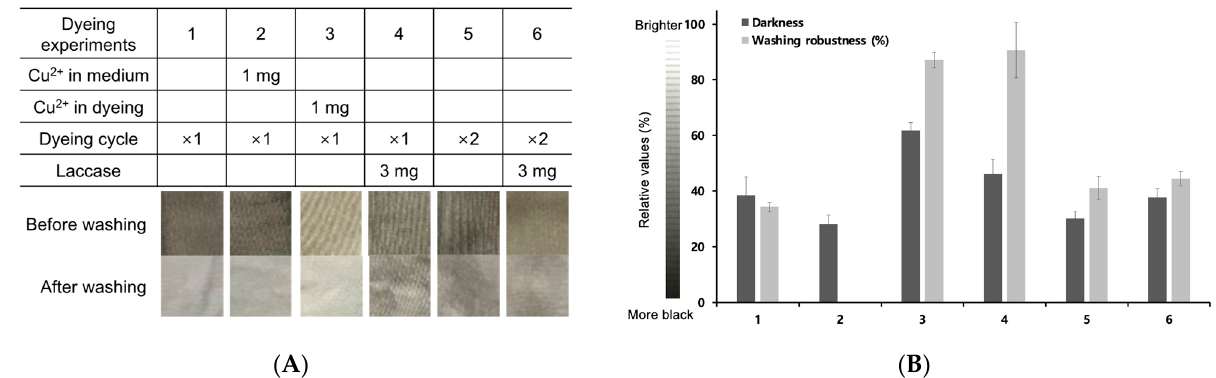
Figure 2. ( A ) Dyeing of S. glaucescens melanin on cotton fabric at different conditions: (1) dyeing with the culture supernatant without copper ions, (2) dyeing with the culture supernatant where melanin was synthesized by adding copper ions to the culture solution, (3) copper ions added to the melanin supernatant during dyeing process, (4) 3 mg (1.5 U) of laccase enzyme treatment to the melanin supernatant during dyeing, (5) double dyeing cycles without copper and laccase enzyme treatment and (6) 3 mg (1.5 U) of laccase enzyme treatment during dyeing and the double dyeing cycles. ( B ) Dyeing performances and dyeing fastness of caffeic acid-based melanin on cotton fabric. The dyeing performance was measured based on the brightness of L in Table 1, and the dyeing fastness was determined through the equation: 100 + [(L + L’)/L] × 100(%), where L is the brightness before washing and L’ is the brightness after washing.